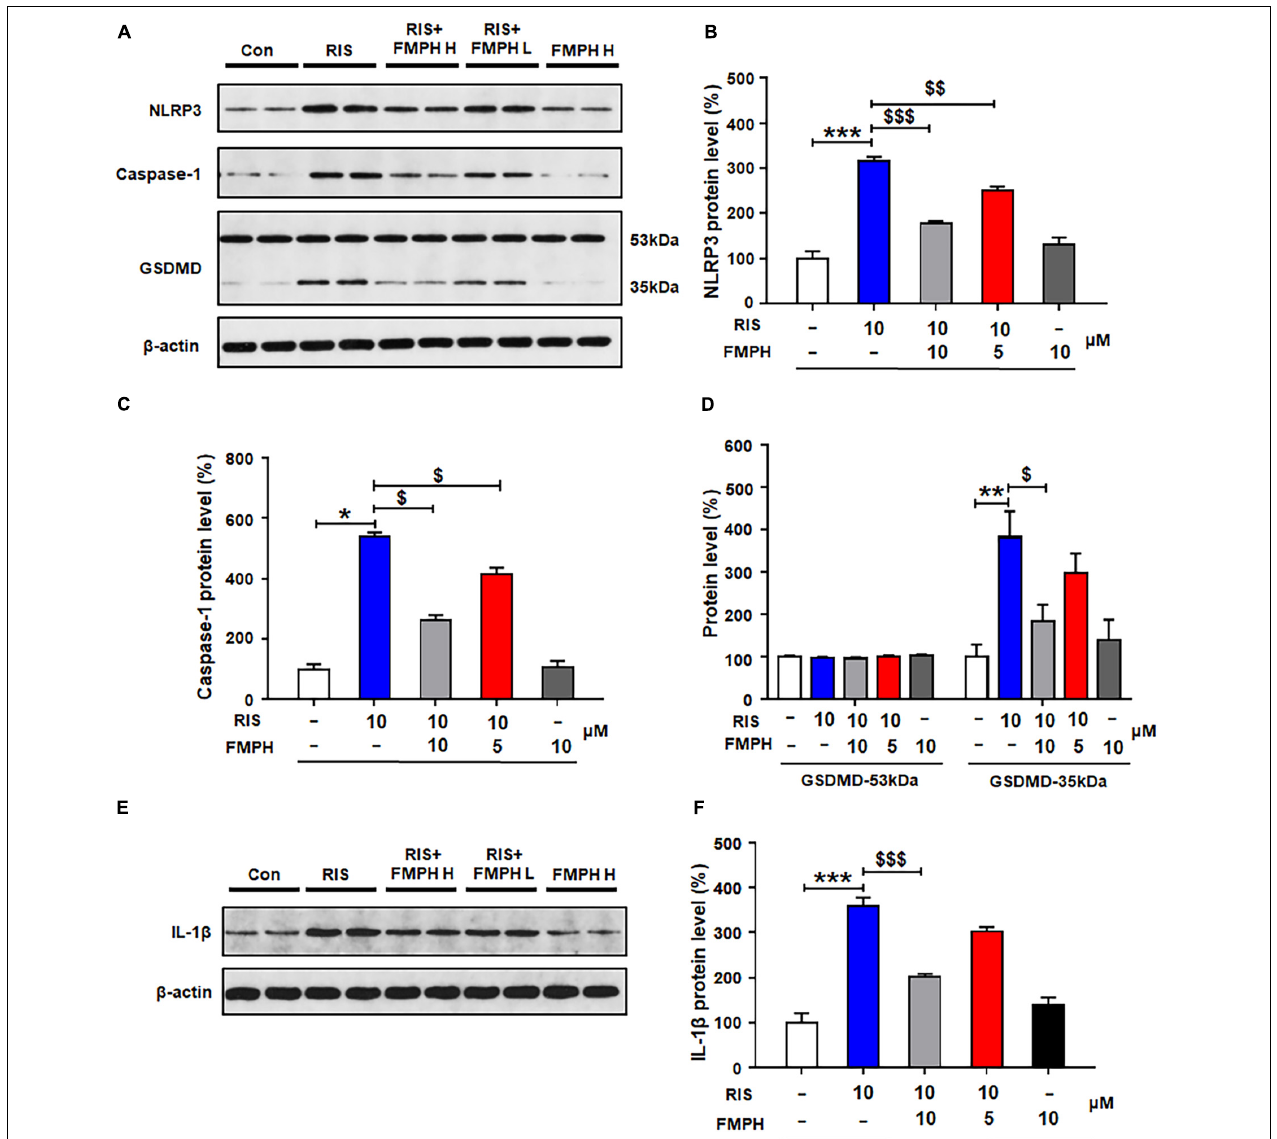
FIGURE 8 | 2-(3-Trifluoromethylphenyl) histamine (FMPH) inhibited risperidone-induced activation of NLRP3/caspase-1 signaling and inhibited IL-1 β protein expression in cultured astrocytes. (A–F) Cultured cells were treated with vehicle [dimethyl sulfoxide (DMSO) + water], risperidone 10 µ M, risperidone 10 µ M + FMPH 10 µ M, risperidone 10 µ M + FMPH 5 µ M, or FMPH 10 µ M for 24 h. Western blot was used to investigate the expression of NLRP3, caspase-1 (20 kDa), GSDMD (53 and 35 kDa), and IL-1 β . The data are presented as mean ± standard error of the mean. * p < 0.05, ** p < 0.01, *** p < 0.001 vs. Con; $ p < 0.05, $$ p <